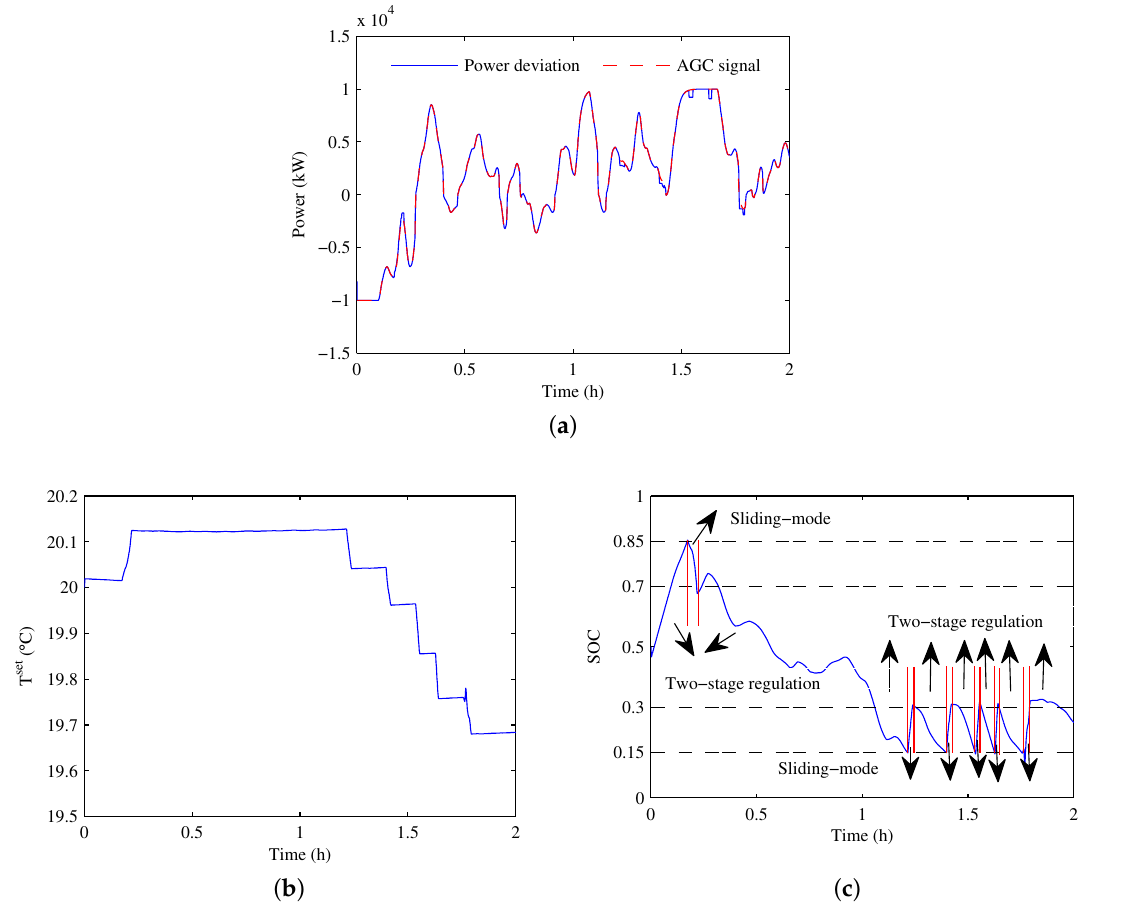
Figure 10. ( a ) AGC signal tracking; ( b ) temperature setpoint trajectory; ( c ) SOC of Switched Control